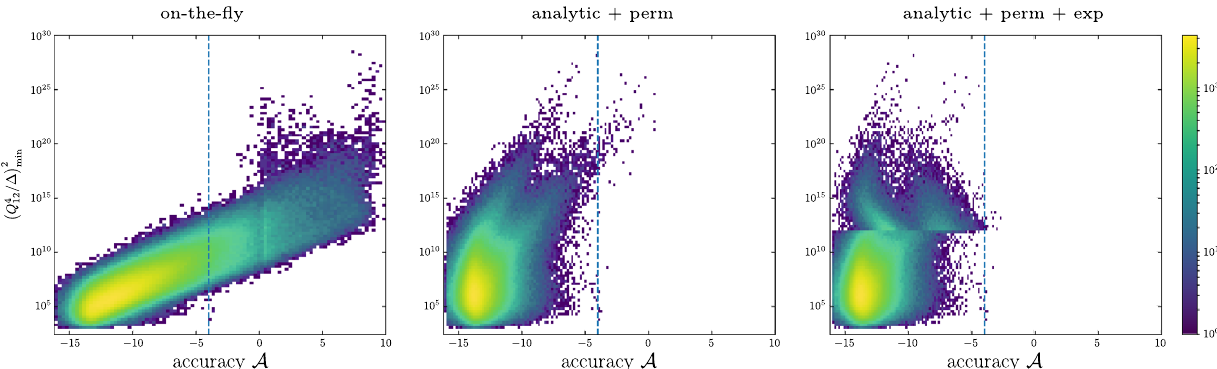
Fig. 15 Correlation between the instability A of OpenLoops2 in dou- ble precision and the largest ( Q 4 /Δ) 2 in the event, where Δ is any rank-two Gram determinant and Q 2 is the maximum scale in the corre- sponding Gram matrix. See (141). Probability densities correspond to